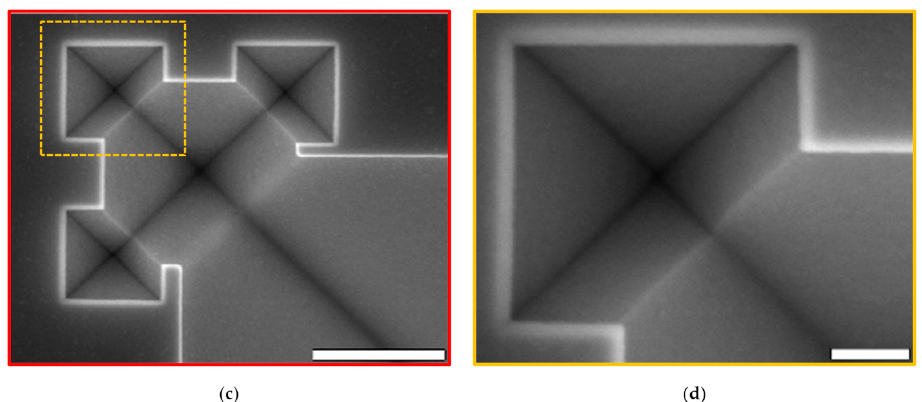
Figure 16. SEM top-view images of the G4 in-plane fractal formation after TMAH and stripping of SiO 2 layer. Enlarged areas are indicated in red and orange dashed lines. Scalebars: ( a , b ) 5 µm, ( c ) 500 nm and ( d ) 100 nm.